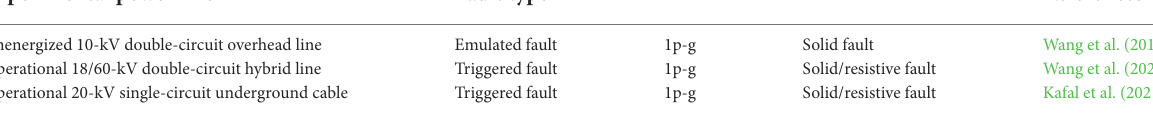
TABLE 1 Full-scaleexperimentsvalidatingtheEMTR-basedfaultlocationmethod. Experimental power